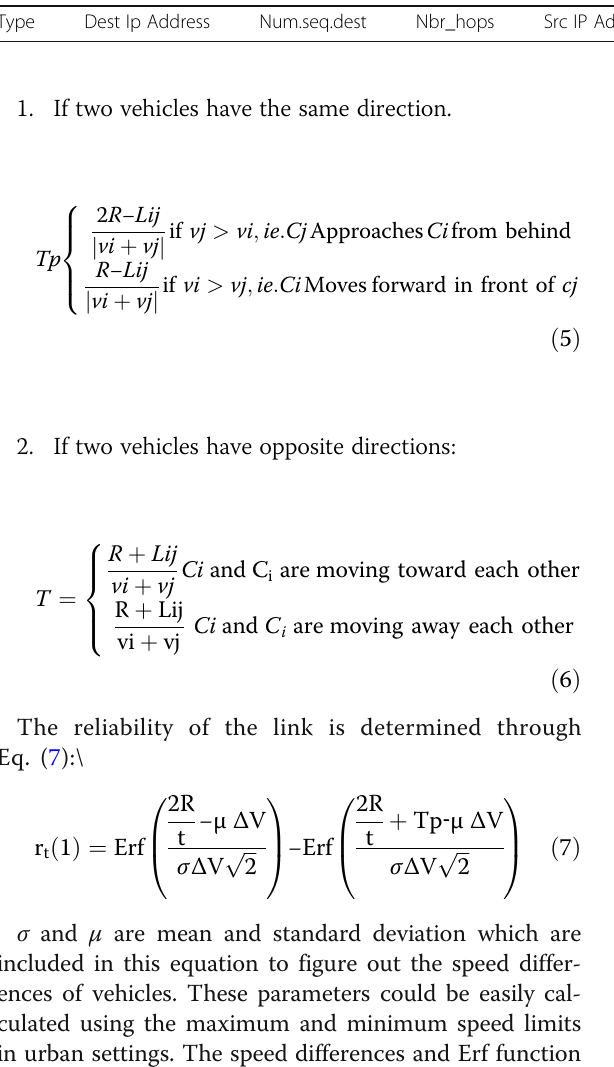
Table 4 Structure of the RREP